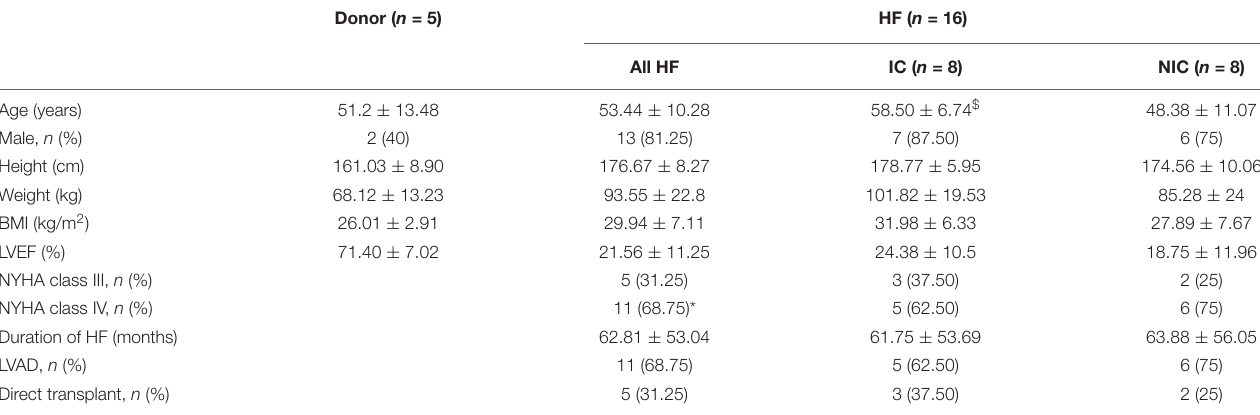
TABLE 1 | Baseline demographic and clinical characteristics of donor and heart failure (HF)